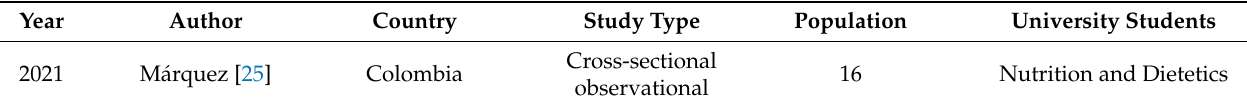
Table 1. Baseline characteristics of the included